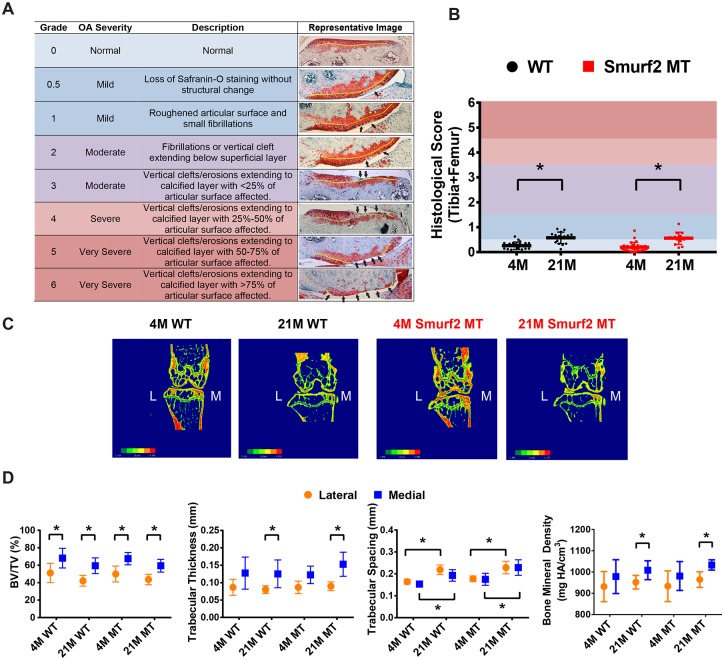
Age-specific knee joint phenotypes of male WT (+/+) and Smurf2-deficient MT (T/T) mice.(A) Normal and osteoarthritic joint articular cartilage histology scoring criteria modified over literature method[27] along with representative safranin O-stained cartilage sections. Yellow line indicates tidemark; Black arrows denote loss of staining, fibrillations, or erosions. (B) Combined histology scores of femoral and tibial articular cartilage of 4 month old WT (n = 13), 4 month old MT (n = 13), 21 month WT (n = 11), and 21 month old MT (n = 11). (C) Representative microCT images of bone mineral density color mappings of mid-frontal knee sections from young and old WT and Smurf2 MT mouse knees. Red indicates higher BMD while green indicates lower BMD. D) Quantitative comparisons of the lateral and medial subchondral bone analyses between 4 month (WT: n = 9; MT: n = 11) and 21 month (WT: n = 10; MT: n = 8) WT and MT mice. *p<0.05.